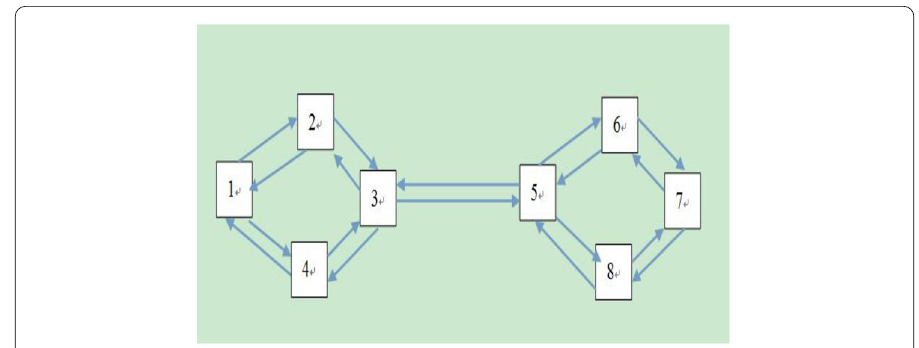
Figure 1 Strongly connected